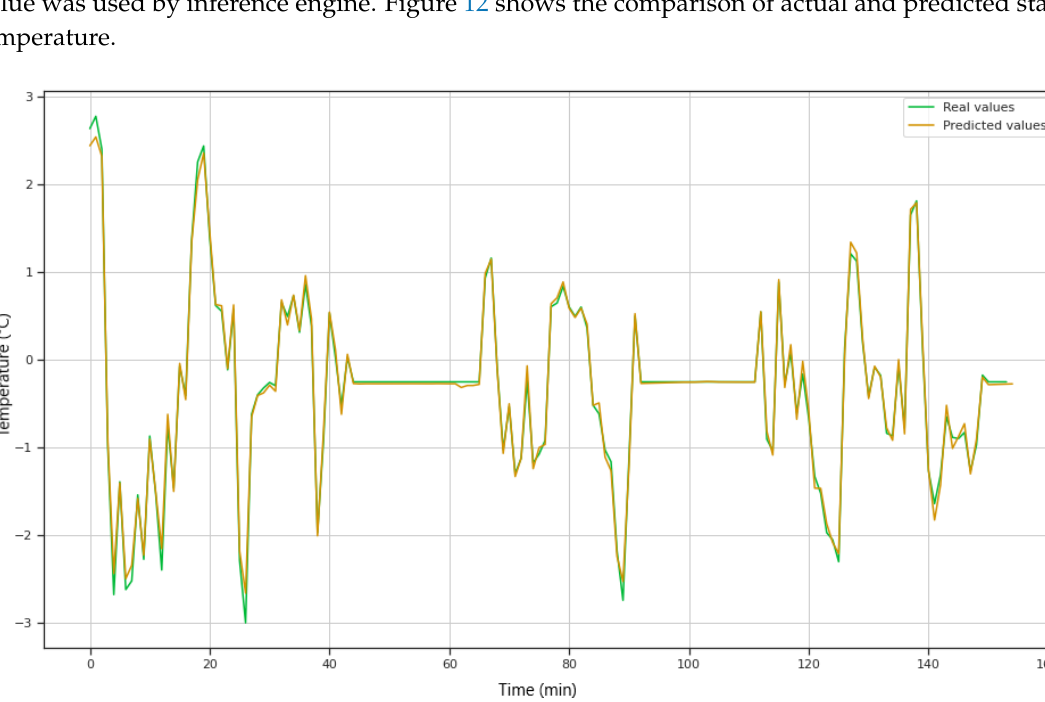
Figure 12. Prediction graph with actual and forecasted